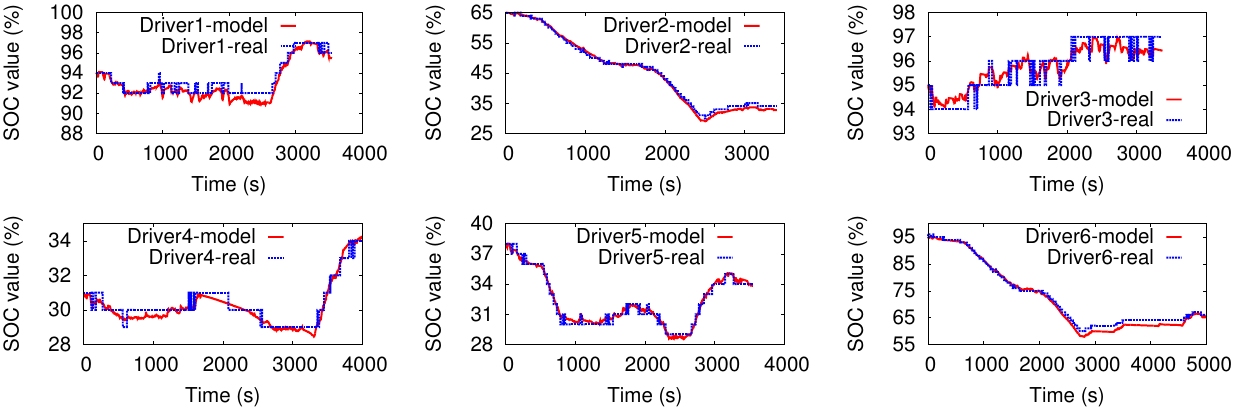
Figure 4. Battery system run-time charge-cycle model